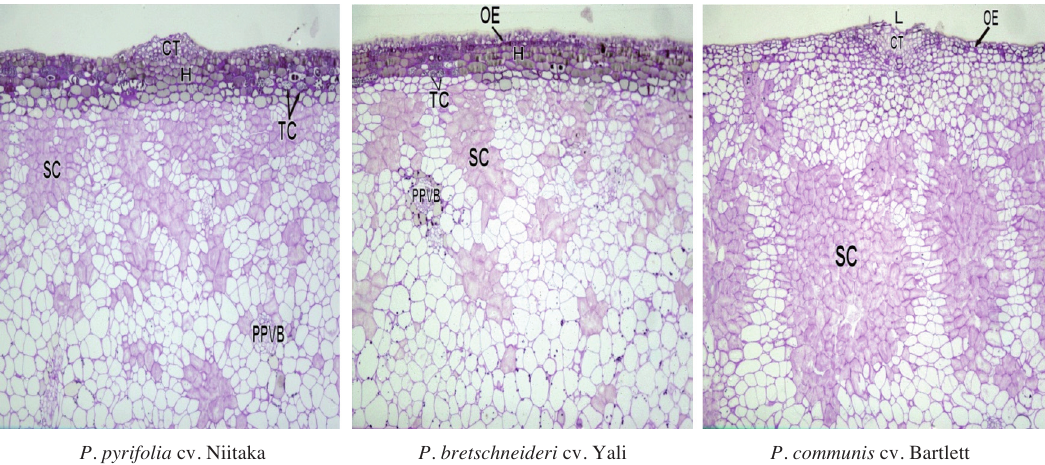
Fig. 1: Comparisons of the distribution and size of stone cells in pear cultivars via light microscopy (100×) at 60 DAFB. CT: complementary cell, H: hypo- dermis, SC: stone cell, PPVB: peripheral vascular bundle, OE: outer epidermis, TC: tannin cell, H: hypodermis, SC: stone cell.